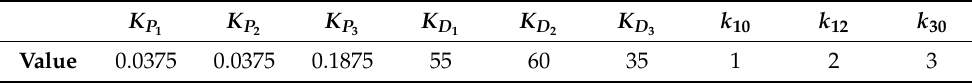
Table 2. Controller parameters used in simulations.